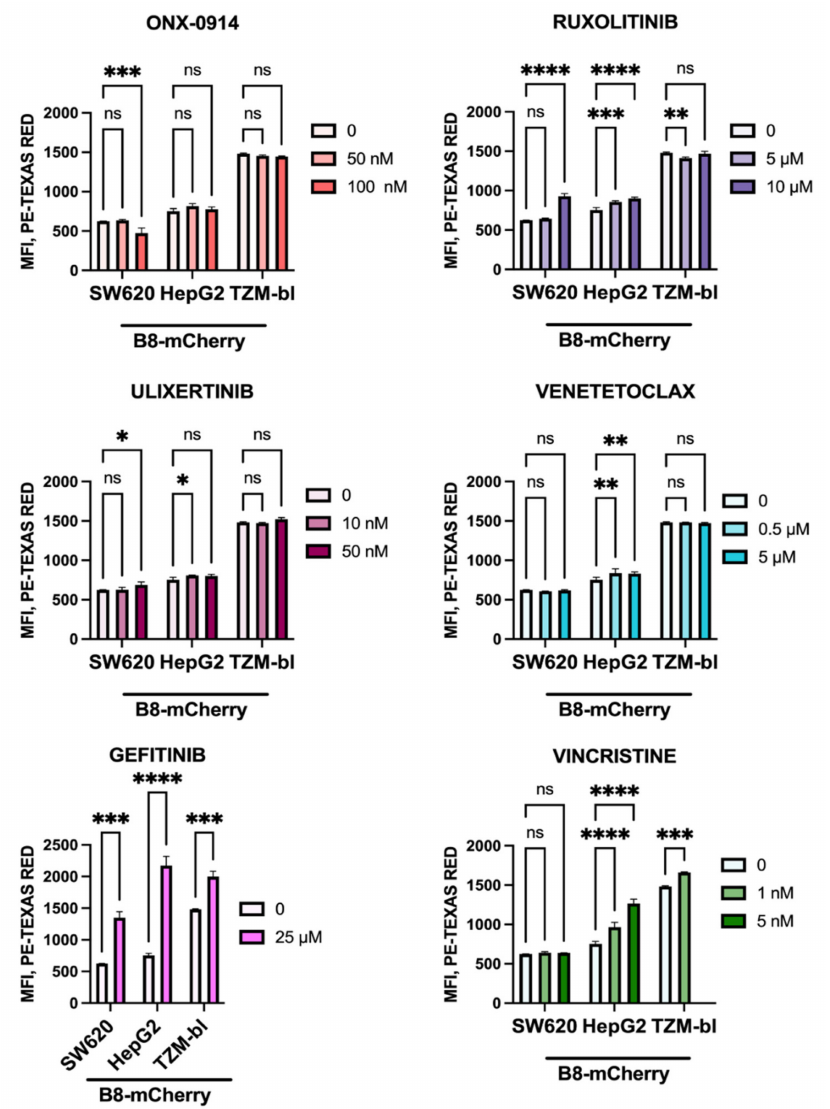
Figure 5. Ruxolitinib, Vincristine and Gefitinib stimulate expression of the β 5i-containing protea- somes in modified cells. The SW620B8-mCherry, TZM-blB8mCherry and HepG2B8mCherry cells were treated with indicated concentrations of anti-cancer drugs Ulixertinib, Venetoclax, Ruxolitinib, Vincristine, Gefitinib and a β 5i-specific inhibitor—ONX-0914 for 72 h. Beta5i-mCherry fluorescence was analyzed in treated cells by flow cytometry. Tests were performed in triplicates. * p < 0.05; ** p < 0.01; *** p < 0.001; **** p < 0.0001; t